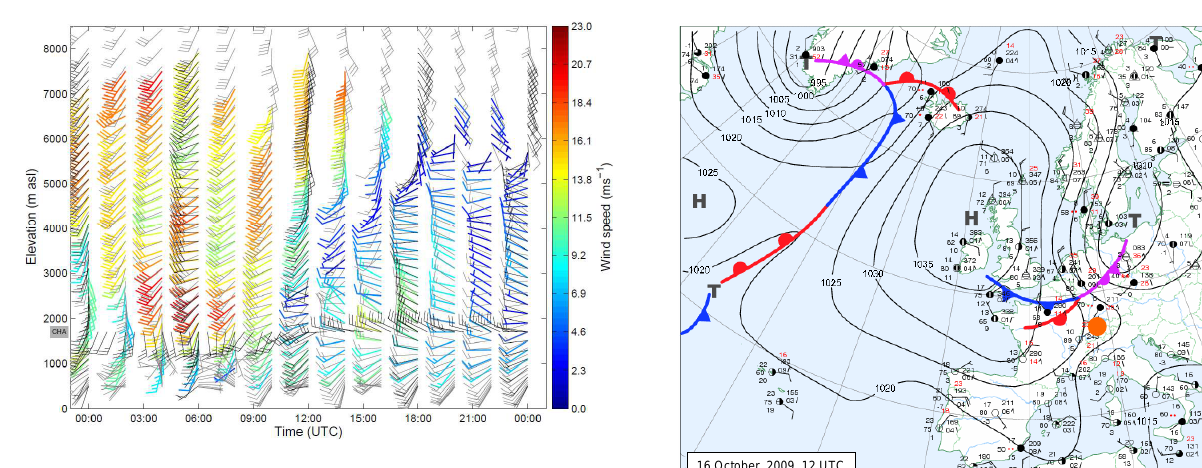
16 October, 2009, 12 UTC Fig. 7. Synoptic situation above Europe (surface), 16 October 2009 at 12:00UTC. Area of interest is shown with an orange